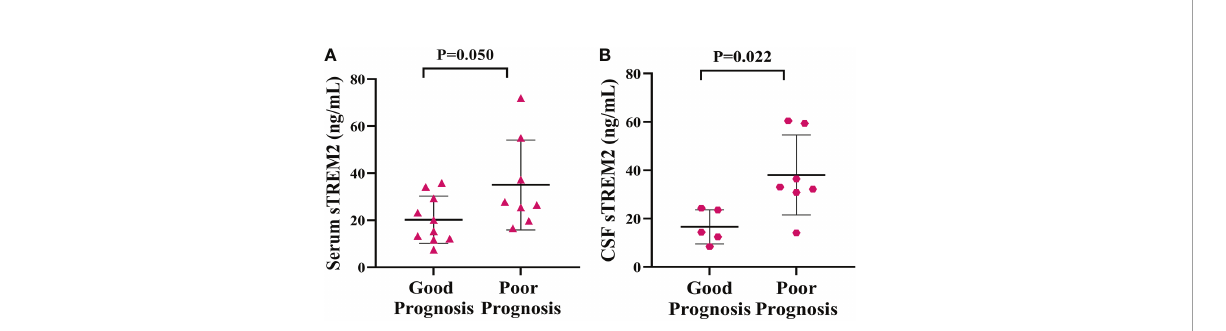
FIGURE 6 Elevated serum and CSF sTREM2 concentrations were linked to a poor prognosis in PACNS patients. (A) The serum sTREM2 concentration in PACNS patients (n=18) was signi fi cantly higher in patients with a poor prognosis (n=6) than in those with a good prognosis (n=12). (B) The CSF sTREM2 concentration in PACNS patients (n=12) also appeared to be signi fi cantly higher in patients with a poor prognosis.